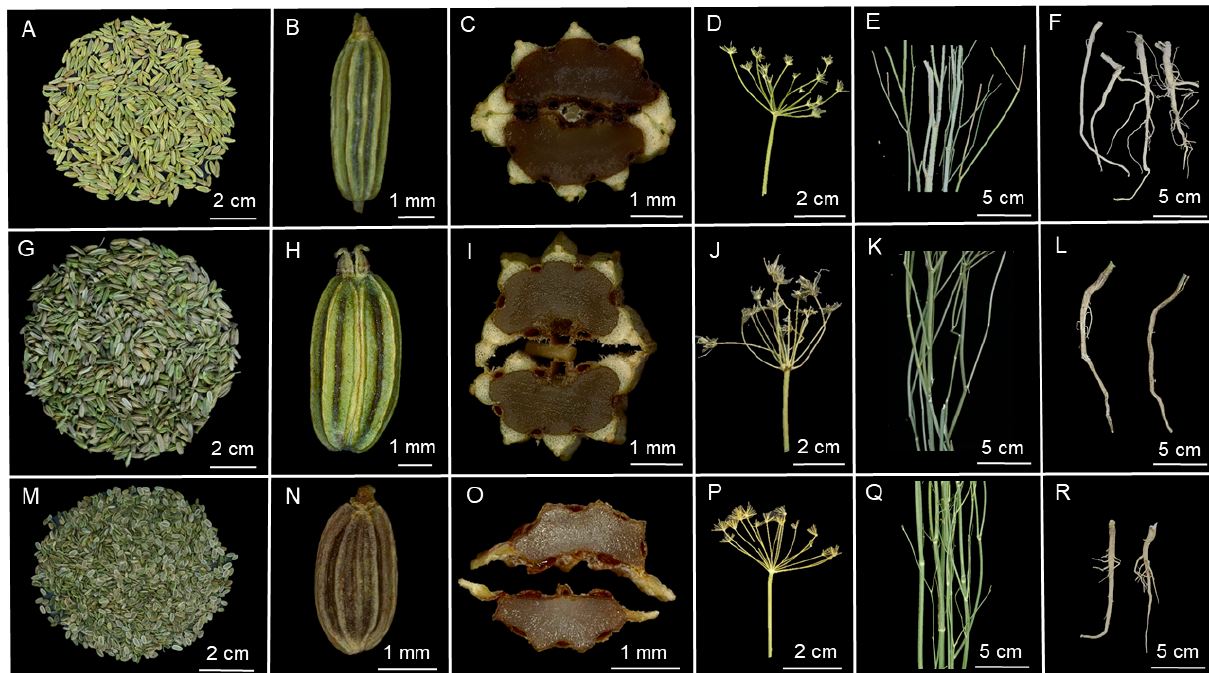
Figure 1. Representative images of different parts of one dill and two fennel cultivars. ( A – C ) Foeniculum vulgare “Dwarf” fruit (Fdf); ( D ) F. vulgare “Dwarf” umbel (Fdu); ( E ) F. vulgare “Dwarf” stalk (Fds); ( F ) F. vulgare “Dwarf” root (Fdr); ( G – I ) F. vulgare “High” fruit (Fdf); ( J ) F. vulgare “High” umbel (Fhu); ( K ) F. vulgare “High” stalk (Fhs); ( L ) F. vulgare “High” root (Fhr); ( M – O ) Anethum graveolens fruit (Agf); ( P ) A. graveolens umbel (Agu); ( Q ) A. graveolens stalk (Ags); ( R ) A. graveolens root (Agr).